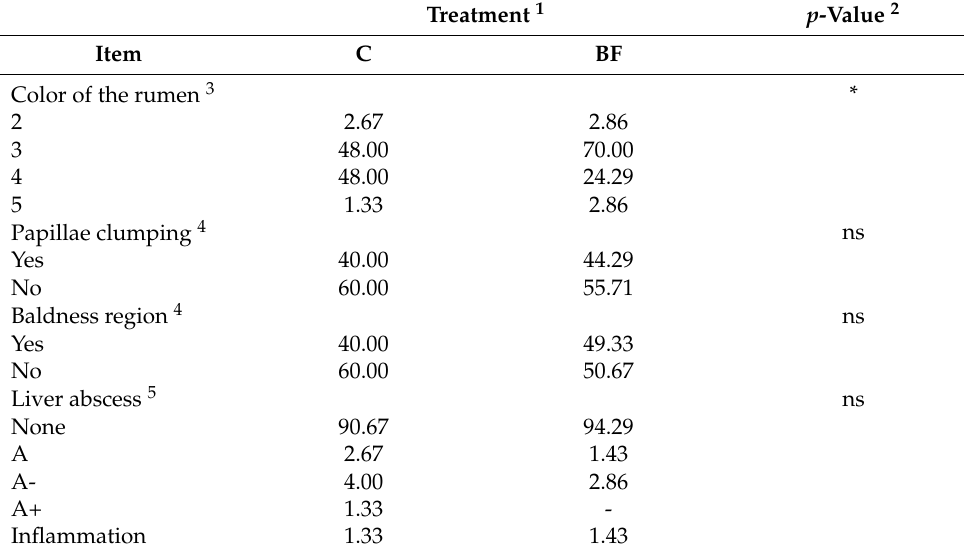
Table 5. Macroscopical observations of the rumen and liver at slaughterhouse of Holstein bulls fed high-concentrate diets supplemented with citrus